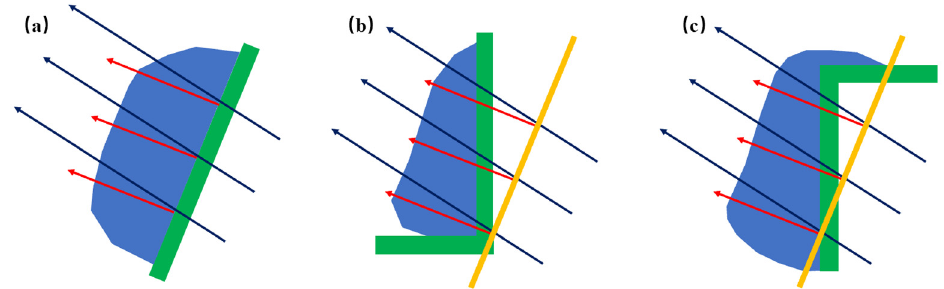
Figure 12. Sketch maps of three ideal wind-driven polynyas. The black arrows indicate the wind direction; the red arrows indicate the direction of the sea ice’s motion; the blue area denotes the polynya; the green box denotes the ice barrier; and the orange line denotes the equivalent linear ice barrier. The red arrow is perpendicular to the ice barrier (in ( a )) or the equivalent linear ice barrier (orange line of ( b , c )), and the black arrows are slightly (about 10°) to the right of the red arrows.